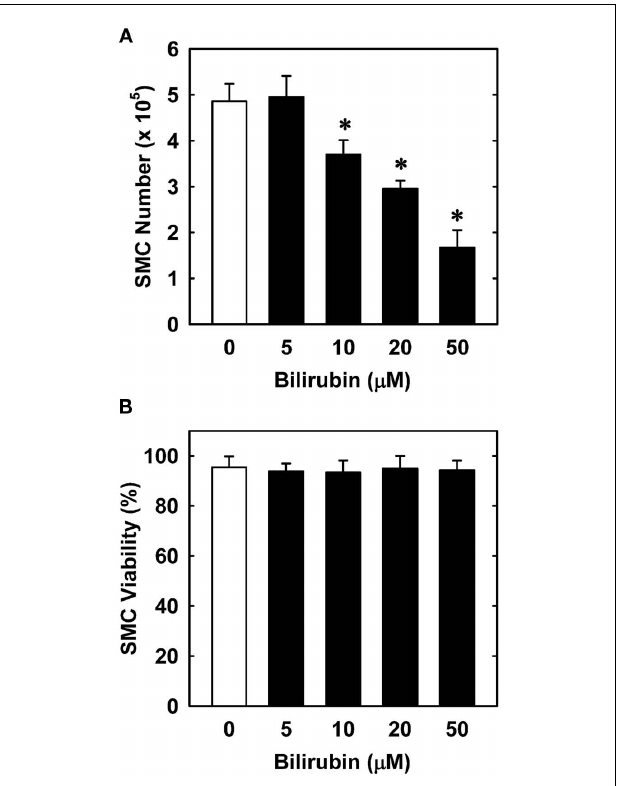
FIGURE 3 | Bilirubin inhibits the proliferation of human vascular SMCs without affecting cell viability. (A) Effect of bilirubin on the proliferation of SMCs. (B) Effect of bilirubin on SMC viability. Cells were treated with serum (20%) in the absence or presence of bilirubin (0–50 μ M) for 4days. Results are means ± SEM ( n = 4–5). *Statistically significant effect of bilirubin.